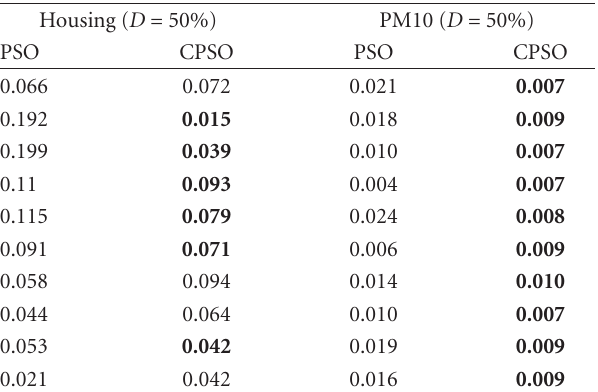
Table 11: Standard deviations for PSO and CPSO (housing and PM10 data